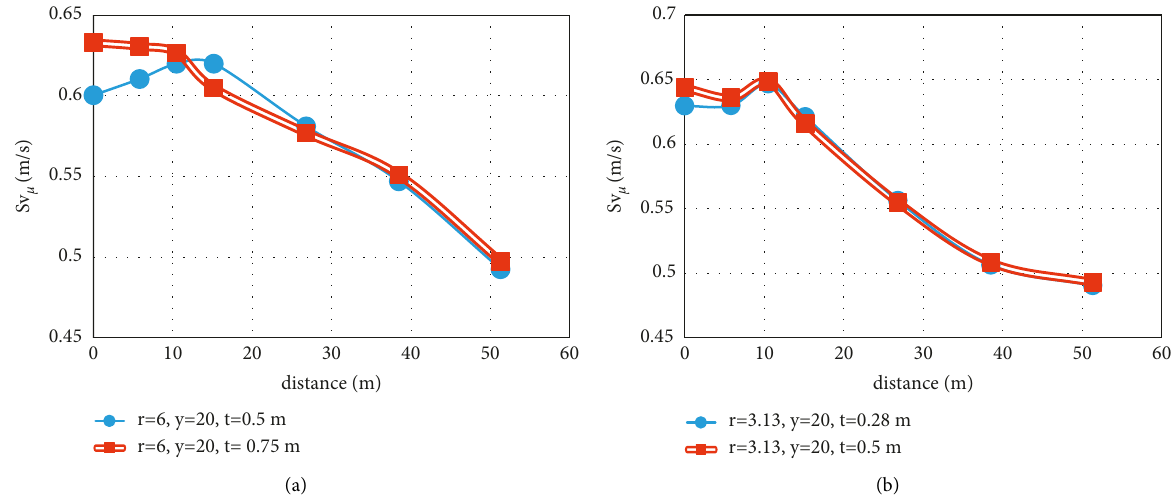
Figure 19: The effect of change in tunnel lining thickness on ground surface velocity for models (a) 24 and 25 and (b) 30 and 31 of Table